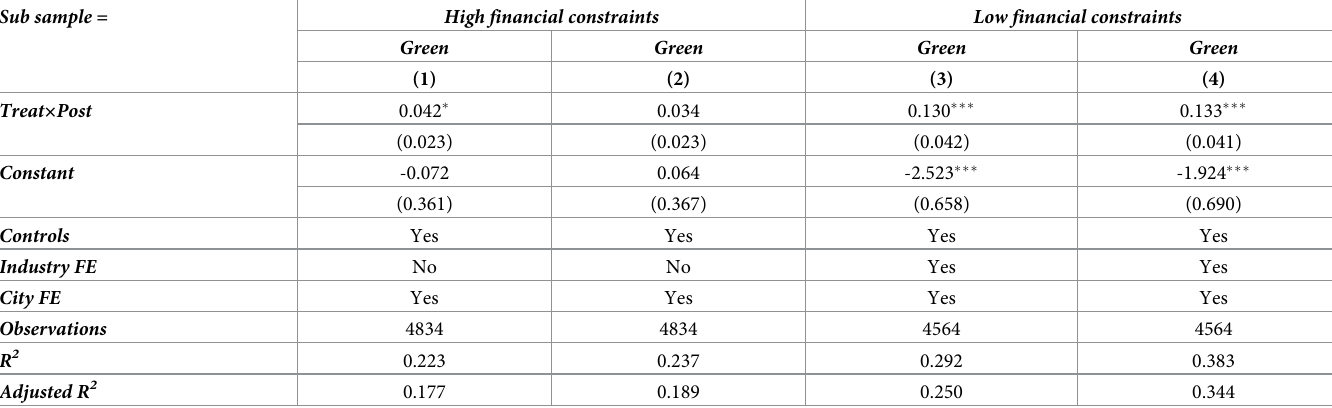
Table 10. Heterogeneity regression results by financial